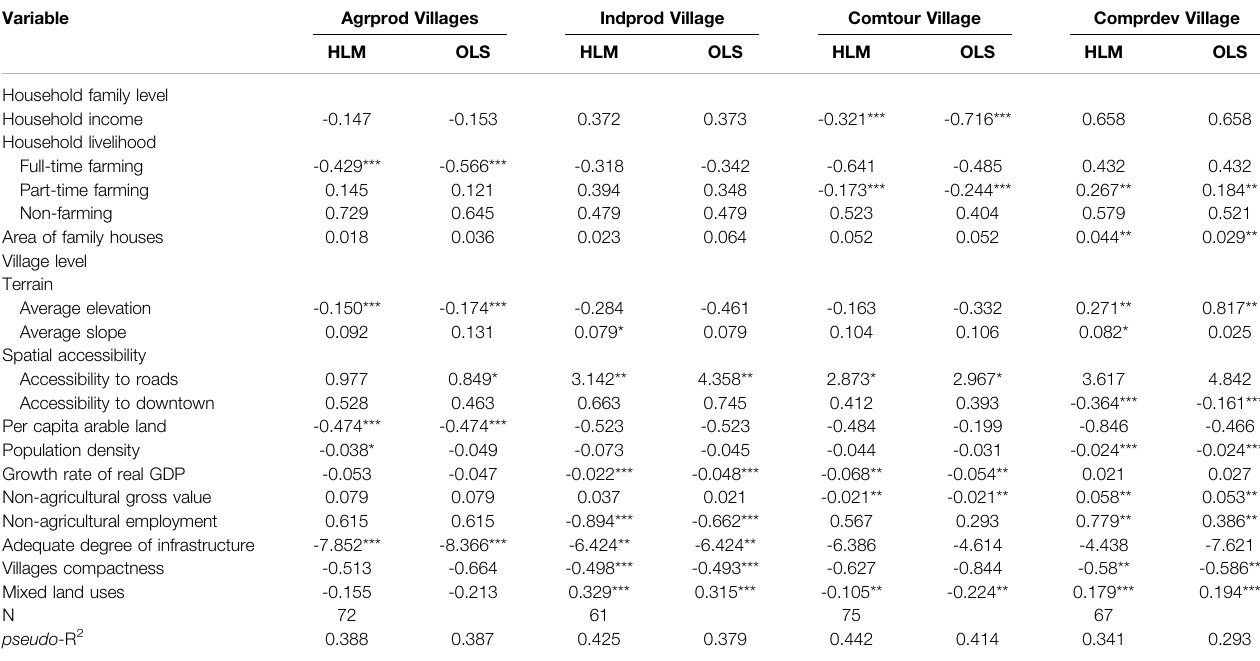
TABLE 5 | Results of HLM and OLS analysis.